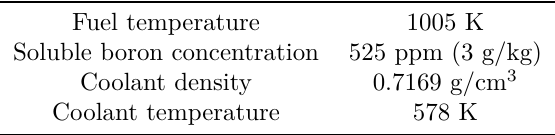
Table 2. Calculation parameters.